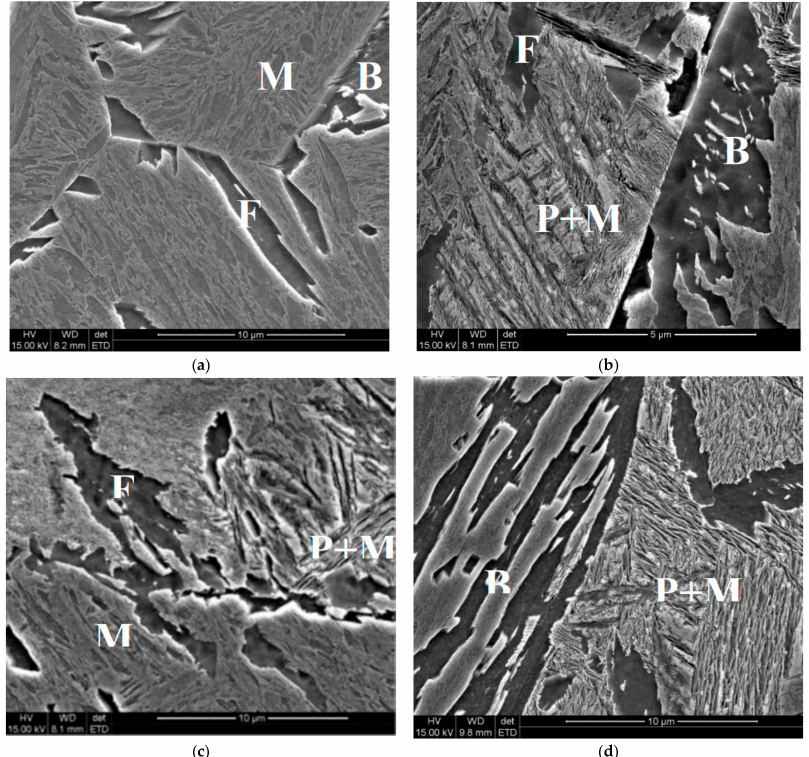
Figure 5. Microstructures of the samples after holding at the temperature of 520 ◦ C for 600 s ( a ), 1000